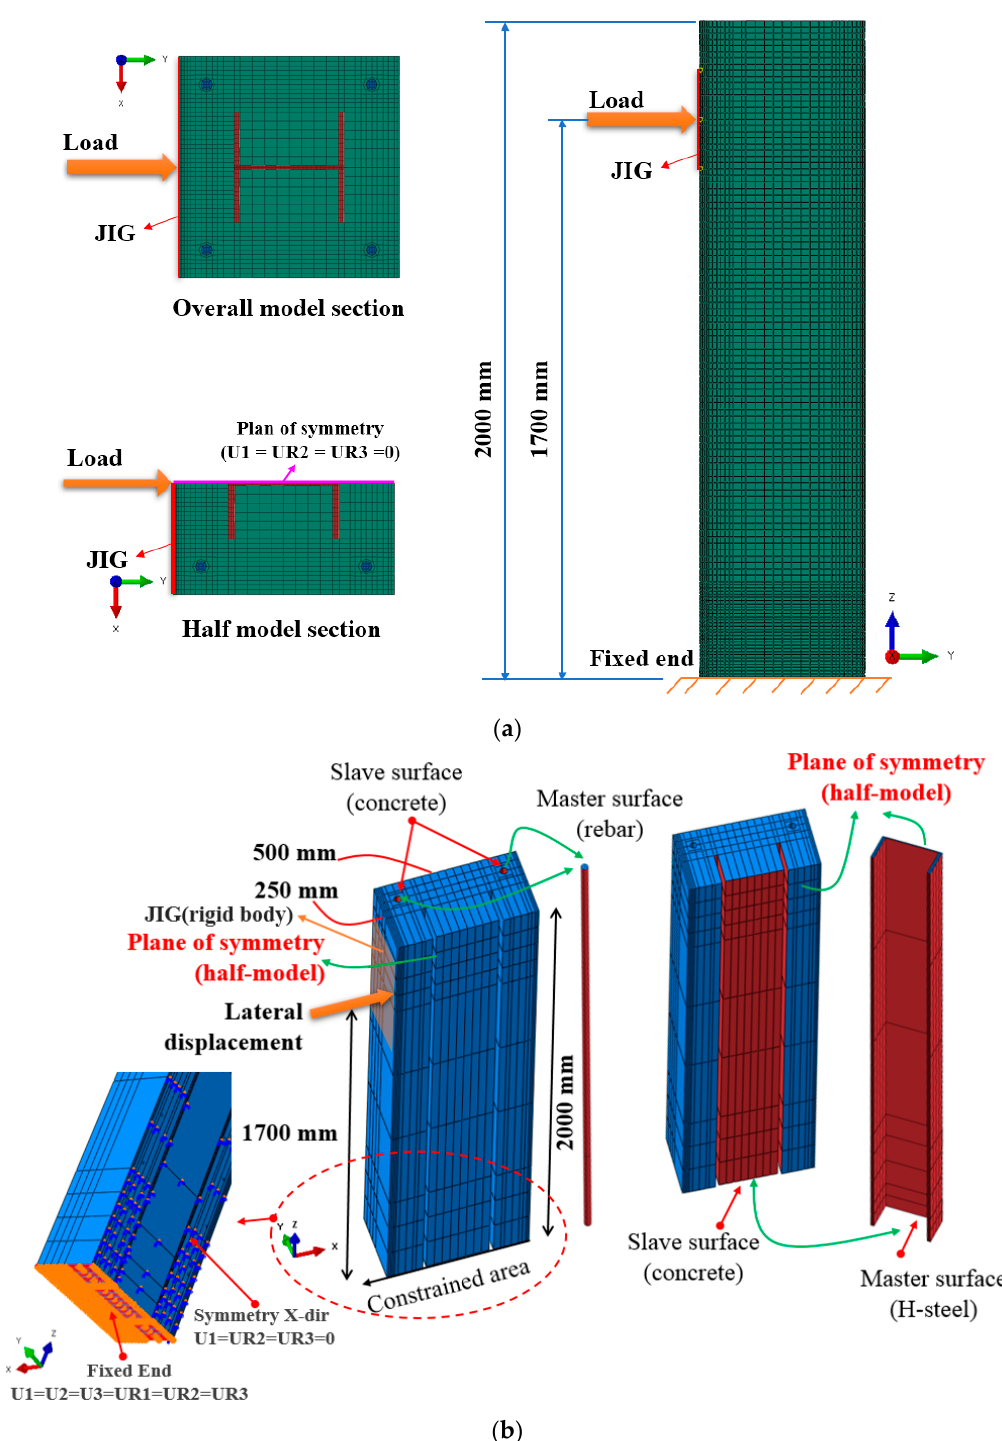
Figure 7. Finite element analysis (FEA) model for verification: ( a ) Overall model with load application; ( b ) definition of interactions: H-steel, reinforcing bars, and concrete.